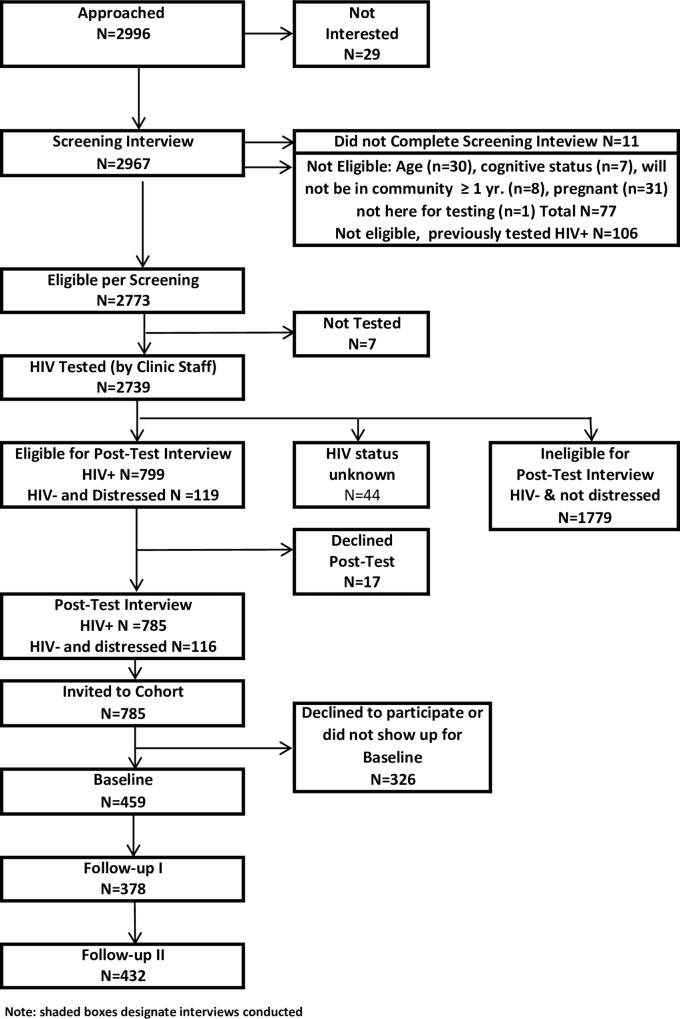
Participant flow for Pathways to Engagement in HIV Care for Newly-Diagnosed South Africans.